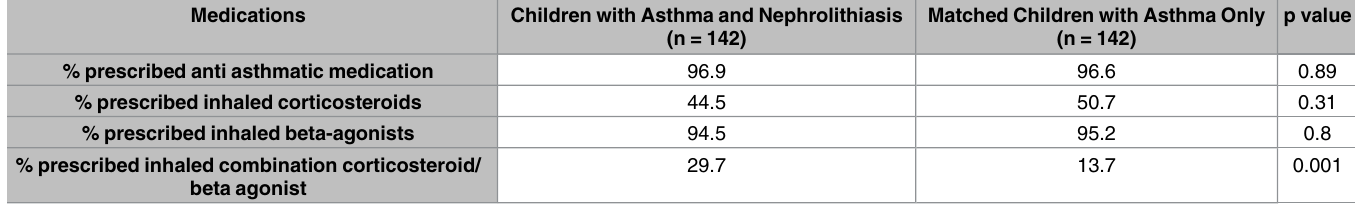
Table 3. Prescribedasthma medication comparison between asthma patients with and without kidney stones matched by age gender and BMI.